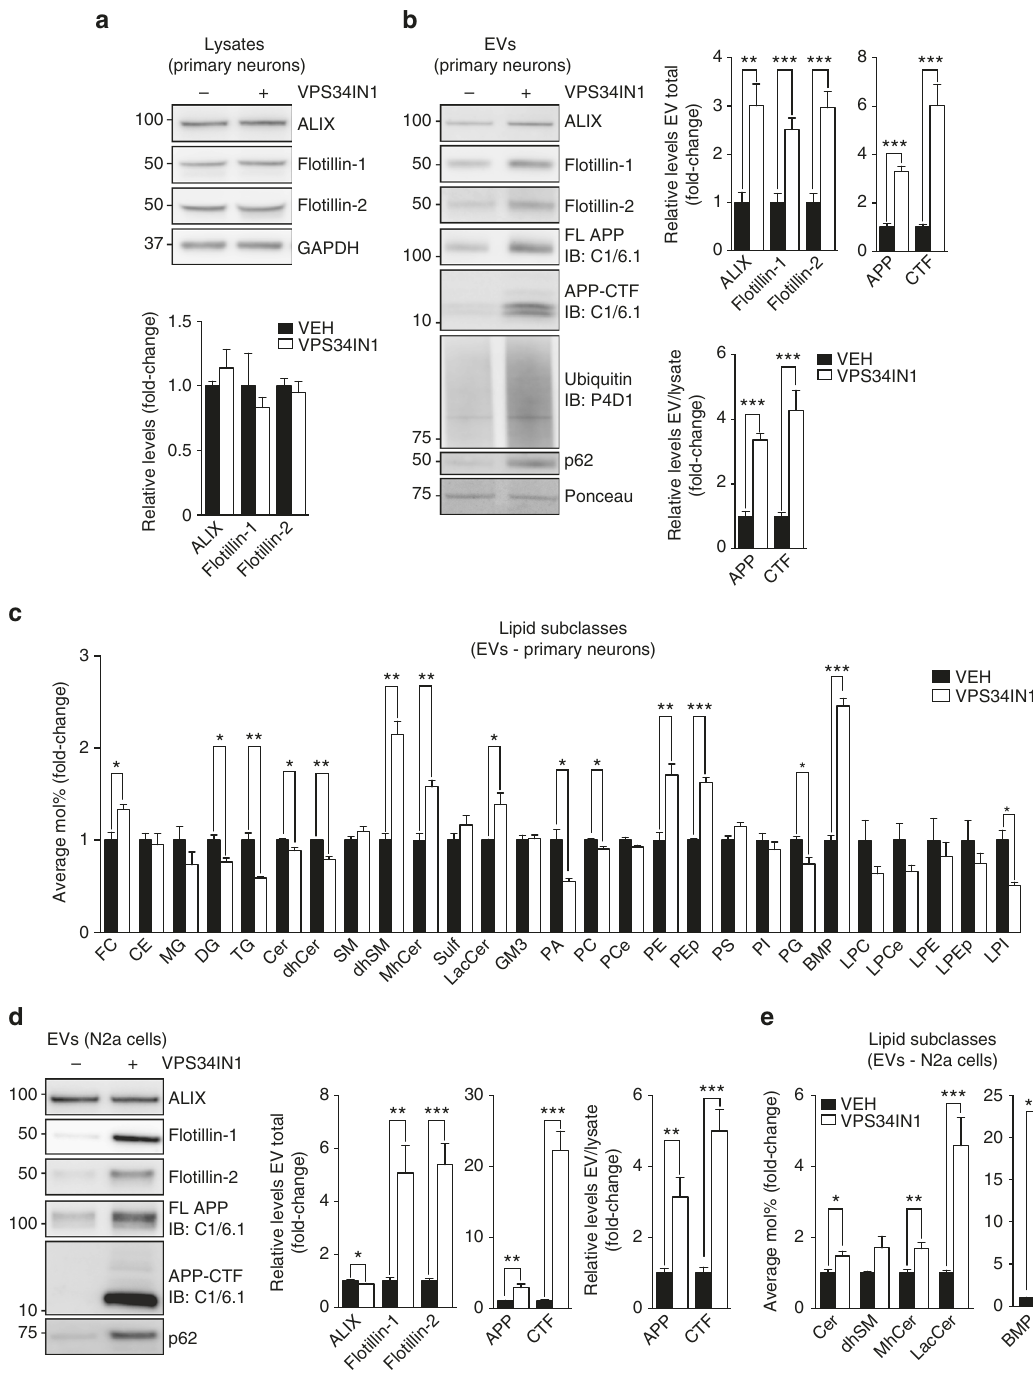
Fig. 4 VPS34IN1 treatment causes secretion of extracellular vesicles (EVs) enriched for APP-CTFs, sphingolipids and BMP. a , b Western blot analysis of cell lysates and EVs from primary cortical neurons treated with vehicle or VPS34IN1 at 3 µ M for 24 h. EV protein levels were normalized to lysate total protein (EV total) or lysate levels of the corresponding protein (EV/Lysate ratio). Bar graph denotes average protein levels normalized to vehicle (mean ± SEM, N = 4 for cell lysates, N = 6 for EVs, from two independent experiments). ** p < 0.01, *** p < 0.001 in two-tailed Student ’ s t test. c LC – MS analysis of lipids extracted from EVs collected from primary cortical neuron culture media after treatment as in a . Values are expressed as average Mol% of total lipid measured, normalized to vehicle (mean ± SEM, N = 3, each from a pool of two biological replicates). * p < 0.05, ** p < 0.01, *** p < 0.01 in two-tailed Student ’ s t test. d , e Western blot and LC – MS analysis of lipids extracted from EVs collected from N2a cell culture media after treatment with vehicle or VPS34IN1 at 1 µ M for 24 h. EV protein levels were normalized to lysate total protein (EV total) or lysate levels of the corresponding protein (EV/Lysate ratio). For complete lipid panel, see Supplementary Fig. 6d (mean ± SEM, N = 6, from two independent experiments). Lipid values are expressed as average Mol% of total lipids measured, normalized to vehicle (mean ± SEM N = 7, each from a pool of two biological replicates) * p < 0.05, ** p < 0.01, *** p < 0.001 in two-tailed Student ’ s t